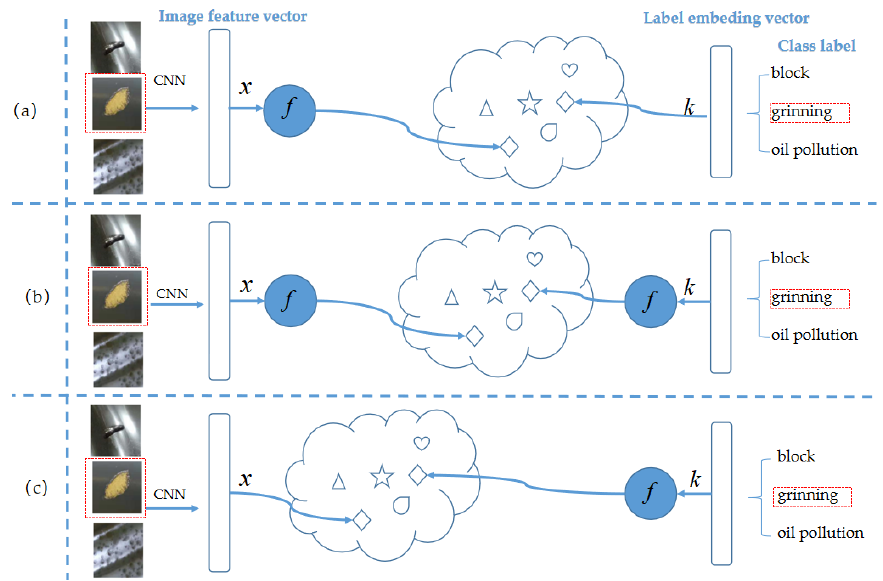
Figure 2. Visual semantic mapping methods. ( a ) Forward mapping, ( b ) Common mapping, ( c ) Reverse mapping